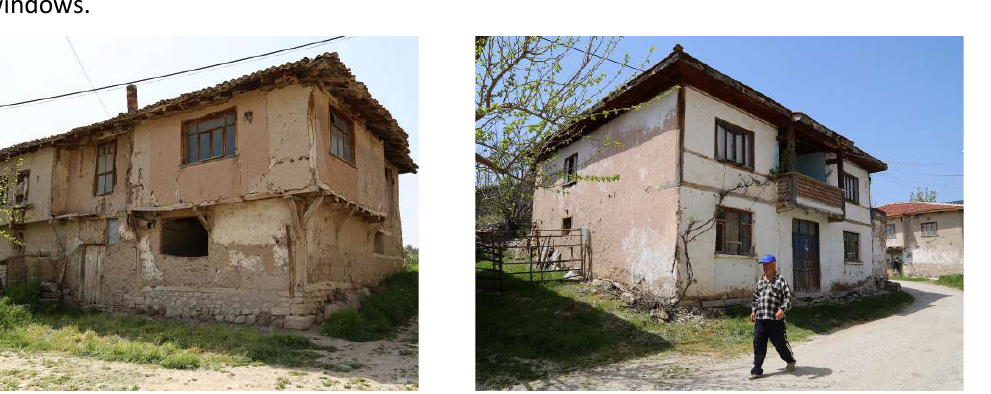
Figure 11 A house in Tongurlar Village Figure 12 A house in Kurşunlu Village (photos: